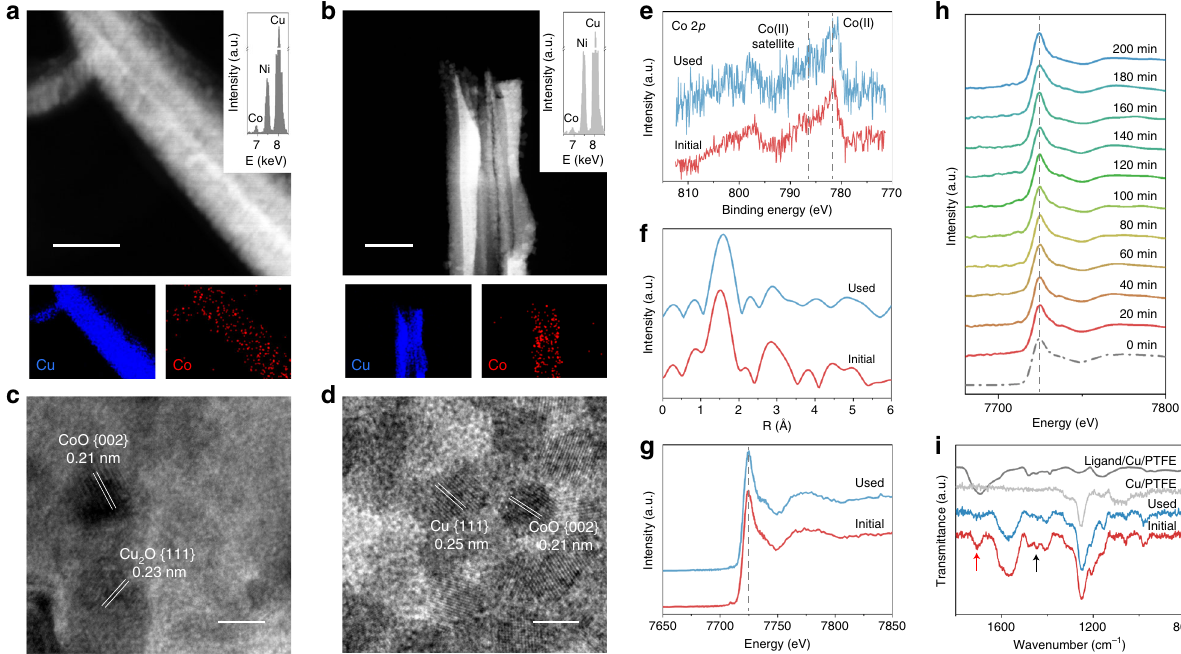
Fig. 4 Structural characterization of electrocatalysts. a , b Dark- fi eld scanning transmission electron micrograph images and corresponding energy-dispersive X-ray spectroscopy mapping for Cu (blue dot) and Co (red dot). c , d High-resolution transmission electron micrograph images of the CoO-2.5nm/Cu/PTFE catalysts before and after stability test. The scale bars in ( a , b ) and ( c , d ) are 200 and 5nm, respectively. e Co 2 p X-ray photoelectron spectroscopy spectra. f The k 2 -weighted Fourier-transform spectra from extended X-ray absorption fi ne structure and g the normalized X-ray absorption near-edge structure spectra at the Co K -edge of the CoO-2.5nm/Cu/PTFE catalysts before and after stability test. Red and blue lines for before and after stability test, respectively. h Operando Co K -edge of X-ray absorption fi ne structure of CoO-2.5nm/Cu/PTFE catalyst under an operating current density of 225mAcm − 2 in a fl ow cell using 1M KHCO 3 electrolyte. i Fourier-transform infrared spectra of the CoO-2.5nm/Cu/PTFE catalysts before and after stability test, compared with the bare and ligand localized Cu/PTFE. Red and blue lines for CoO-2.5nm/Cu/PTFE catalyst before and after stability test, respectively; light grey and dark grey lines for Cu/PTFE and ligand/Cu/PTFE controls, respectively. Red and black arrows for – CO – and – COO – in the poly(methacrylic acid) ligand, respectively. a.u. presents arbitrary